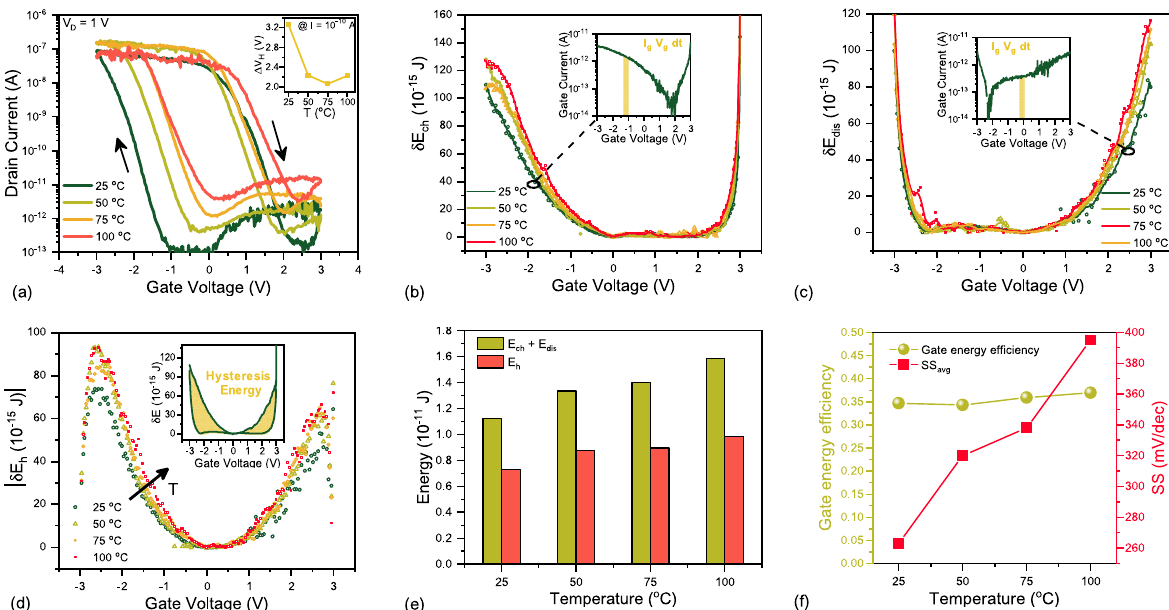
Fig. 4 Electrical and energy behavior characteristics of the 2D/2D FeTFET at high temperatures. a Input transfer characteristics of the 2D/ 2D FeTFET at V d = 1 V for different temperatures. b , c Energy behavior of the FeTFET gate stack in forward and reverse sweeps of V g . d Energy loss of the gate capacitors during a dual sweep of the device. e The total energy consumed during charging/discharging and the energy dissipated due to hysteresis at elevated temperatures. f The gate energy ef fi ciency factor and SS with respect to the investigated